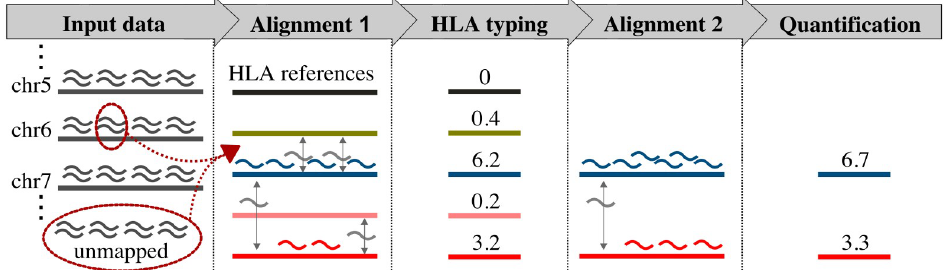
Fig 1. Schematic representation of the HLApers pipeline to estimate HLA expression. The reads generated by RNA-seq are represented by curved shapes. The pipeline can use as input either reads in fastq format or extracted from a BAM file ( Input data ). These reads are aligned to an index containing references for all known HLA alleles ( Alignment 1 ). We next identify the references to which most reads align, so as to infer the HLA genotypes of the individual at that locus, in this example a heterozygote carrying a blue and a red allele ( HLA typing ). Next, a second alignment is performed, using as an index only the references for the alleles inferred to be present in that individual at that locus ( Alignment 2 ). Expression is estimated based on the number of reads aligning to each reference, using a statistical model that accounts for instances where reads align to multiple HLA references corresponding to different HLA alleles or genes ( Quantification ). For each HLA allele, the quantification corresponds to the proportion of the total reads assigned by the statistical model.